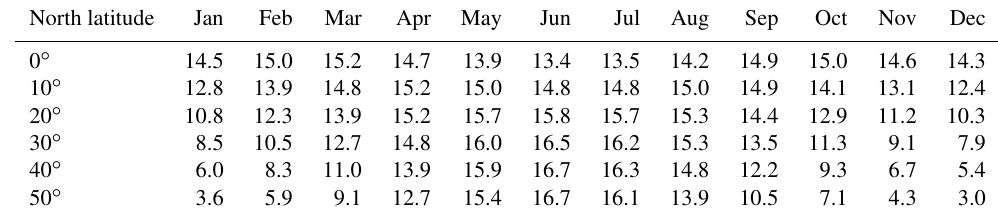
Table B1. Mean monthly solar radiation, H a (in mm), of evaporable water per day. North latitude